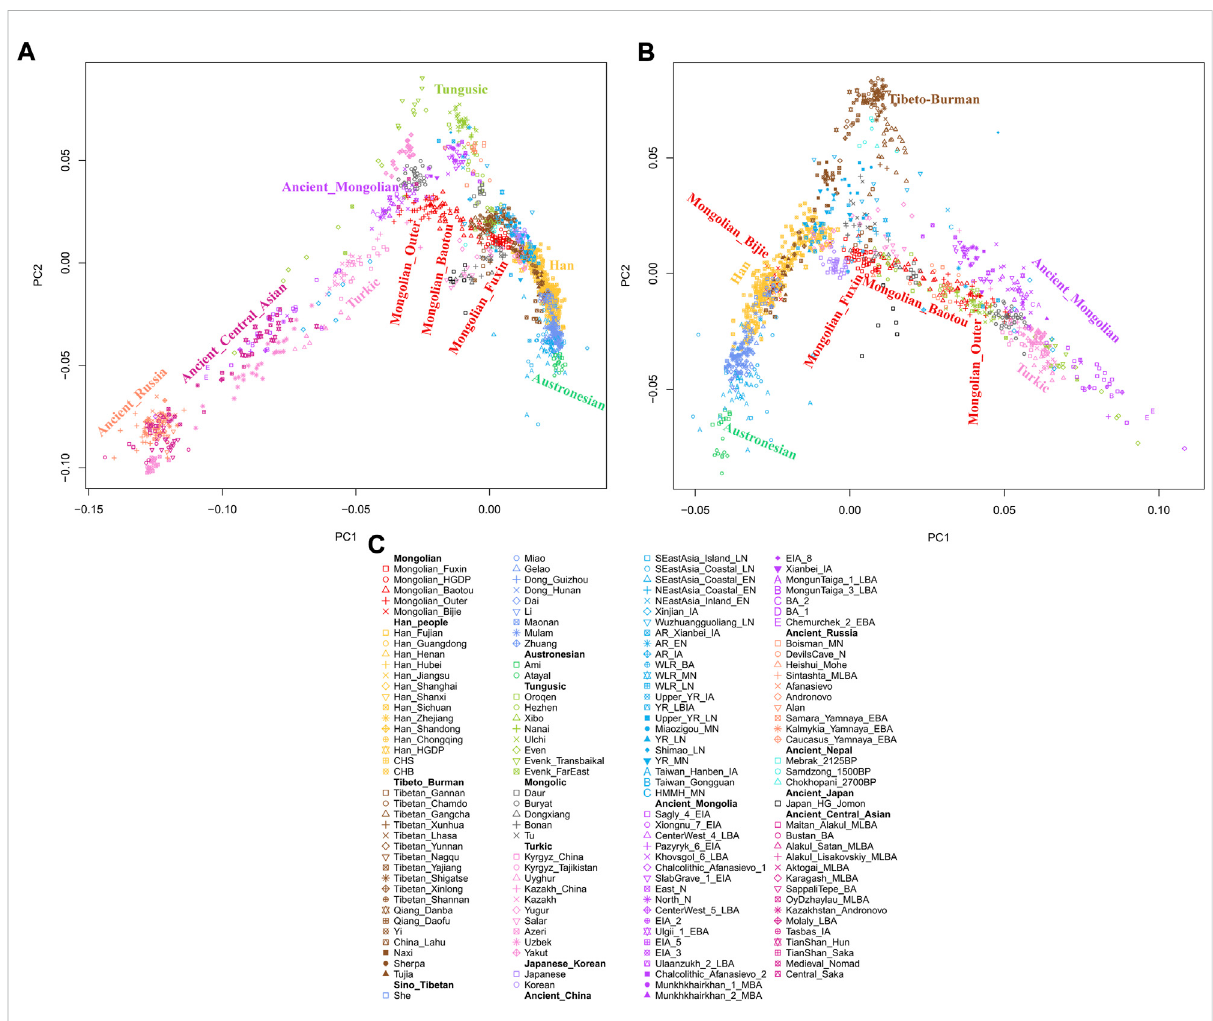
FIGURE 2 The population structure of modern and ancient Eurasian populations inferred by principal component analysis based on genome-wide data. The color of modern population was consistent with language categories, and all ancient populations were projected onto it. (A~B) PCA results showed an overview population relationship between Fuxin Mongolians and other modern and ancient populations. (C) Population list of